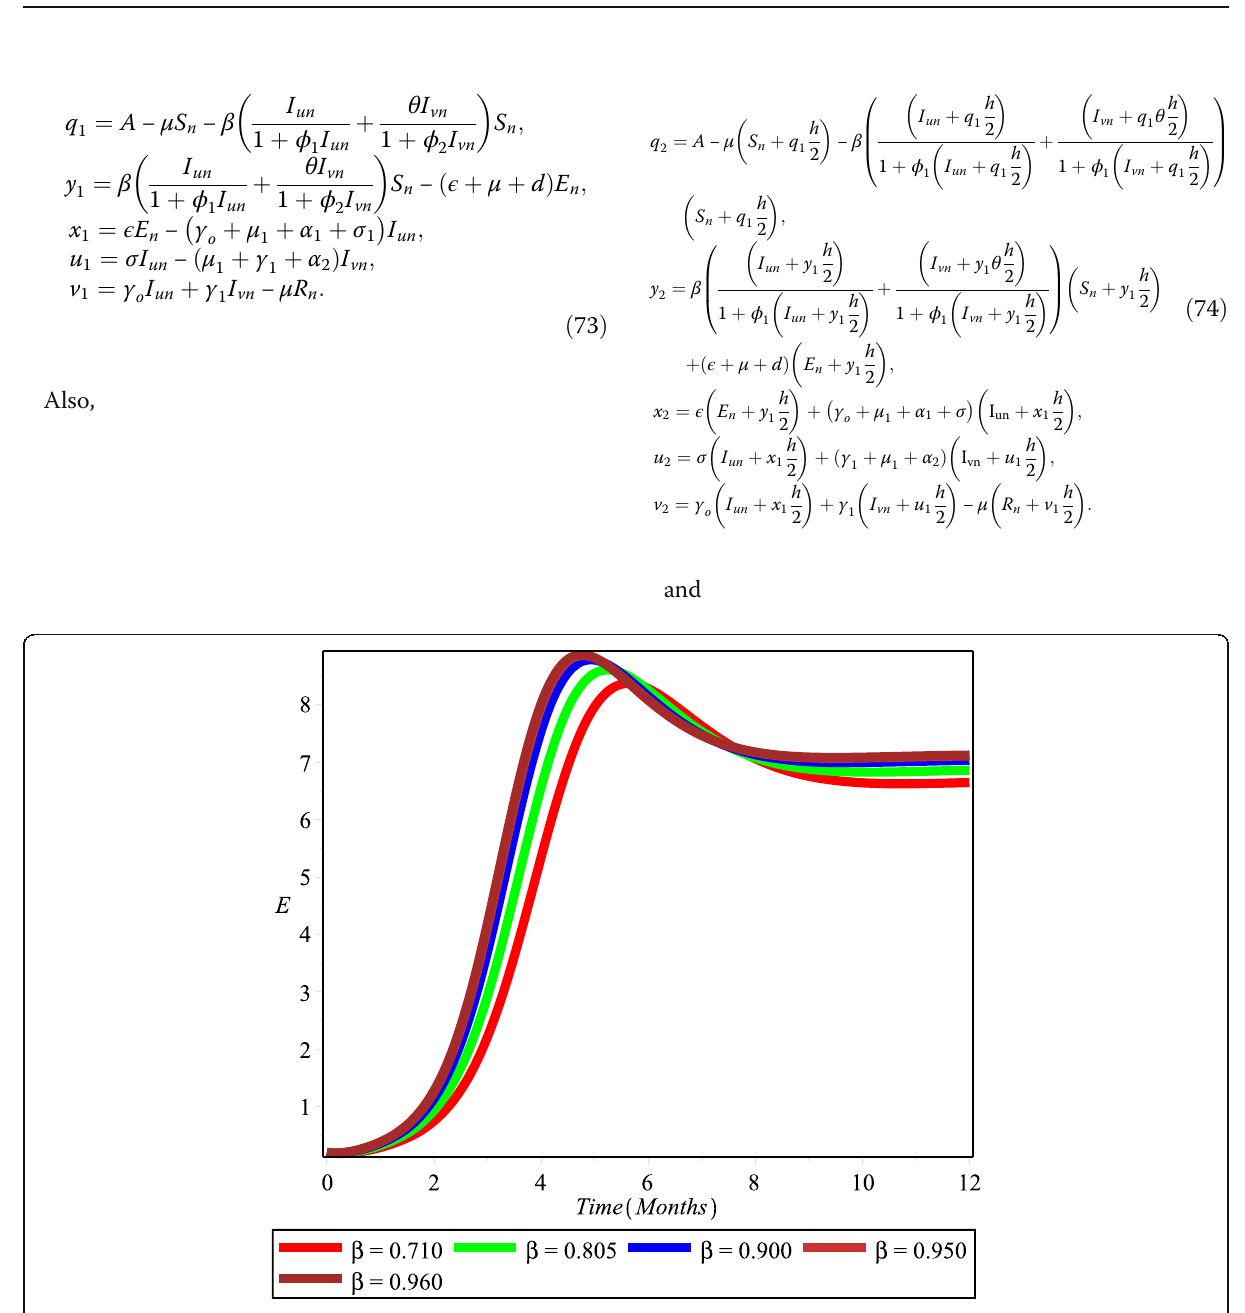
Fig. 1 Varying β (0.001 − 0.027) when R r <